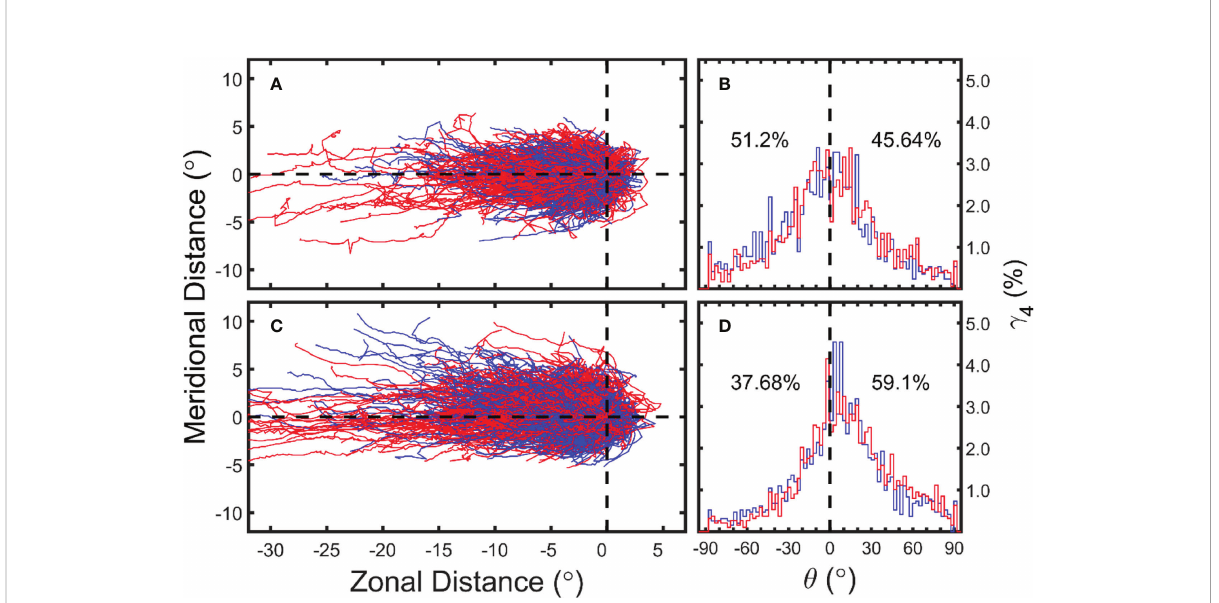
FIGURE 10 Trajectories of eddies generated (A) north and (C) south of 21°N in the STCC region at the sea surface. East and North directions are positive, and the West and South are negative. (B) and (D) show the statistical histogram of eddy trajectory de fl ection azimuth. Blue and red indicate CEs and AEs,